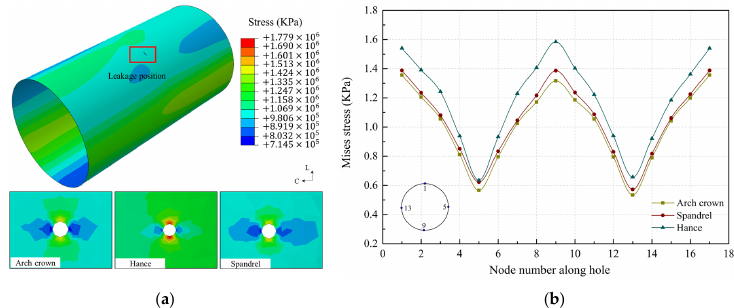
Figure 13. The influence of local damage in different positions: ( a ) Von Mises stress distribution; and ( b ) Von Mises stress curves.